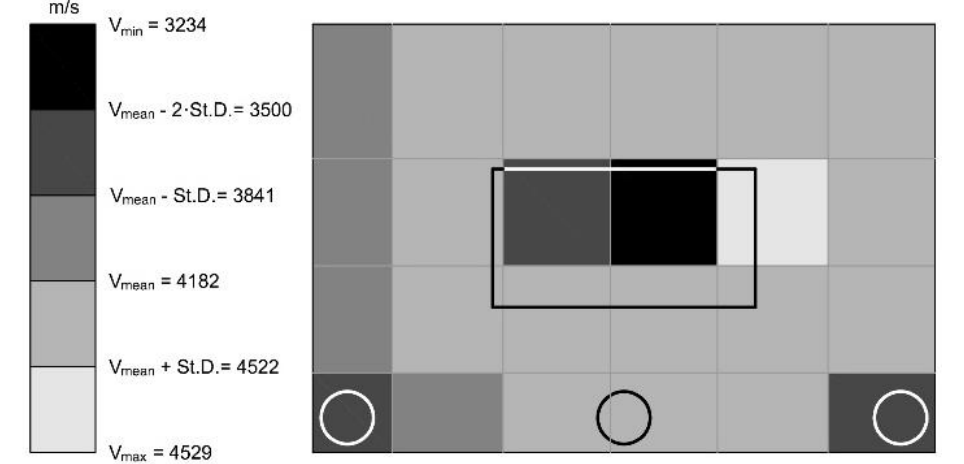
Figure 7. Map 5: Grid E. Levels of velocity.